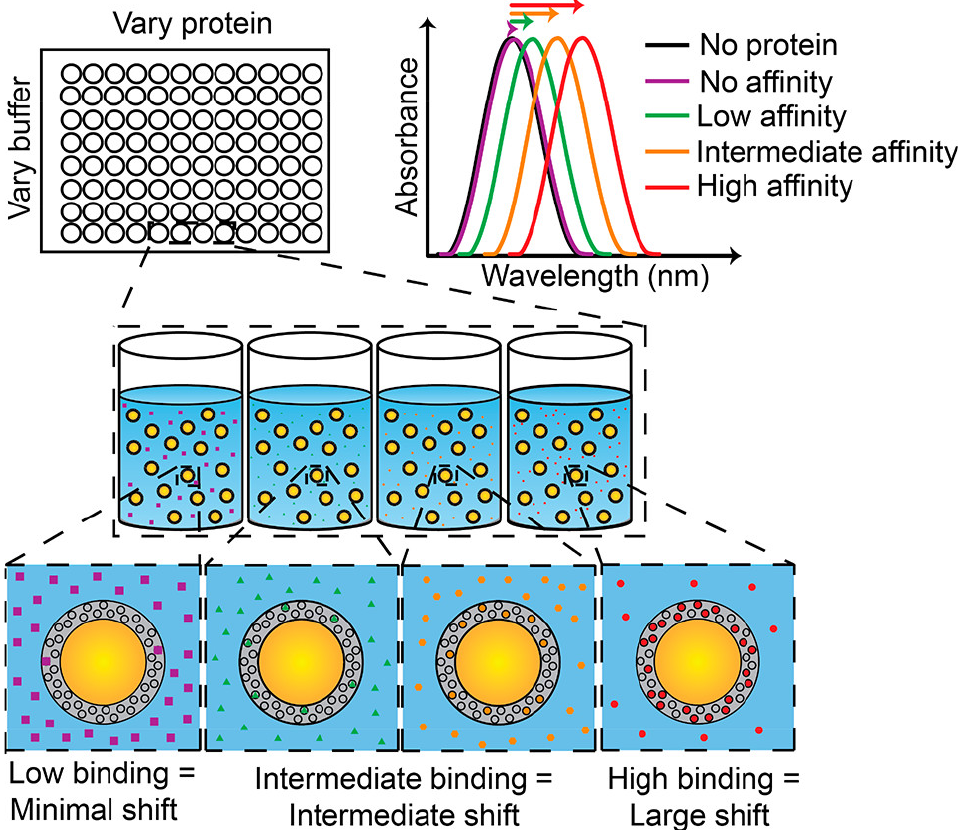
Figure 11. Abridged general view of the AuNS@PNM eye tears biosensor. When the protein concentration or affinity increases, the LSPR wavelength is expected to show a red shift. Reproduced with permission from reference [91]. Copyright 2018 American Chemical